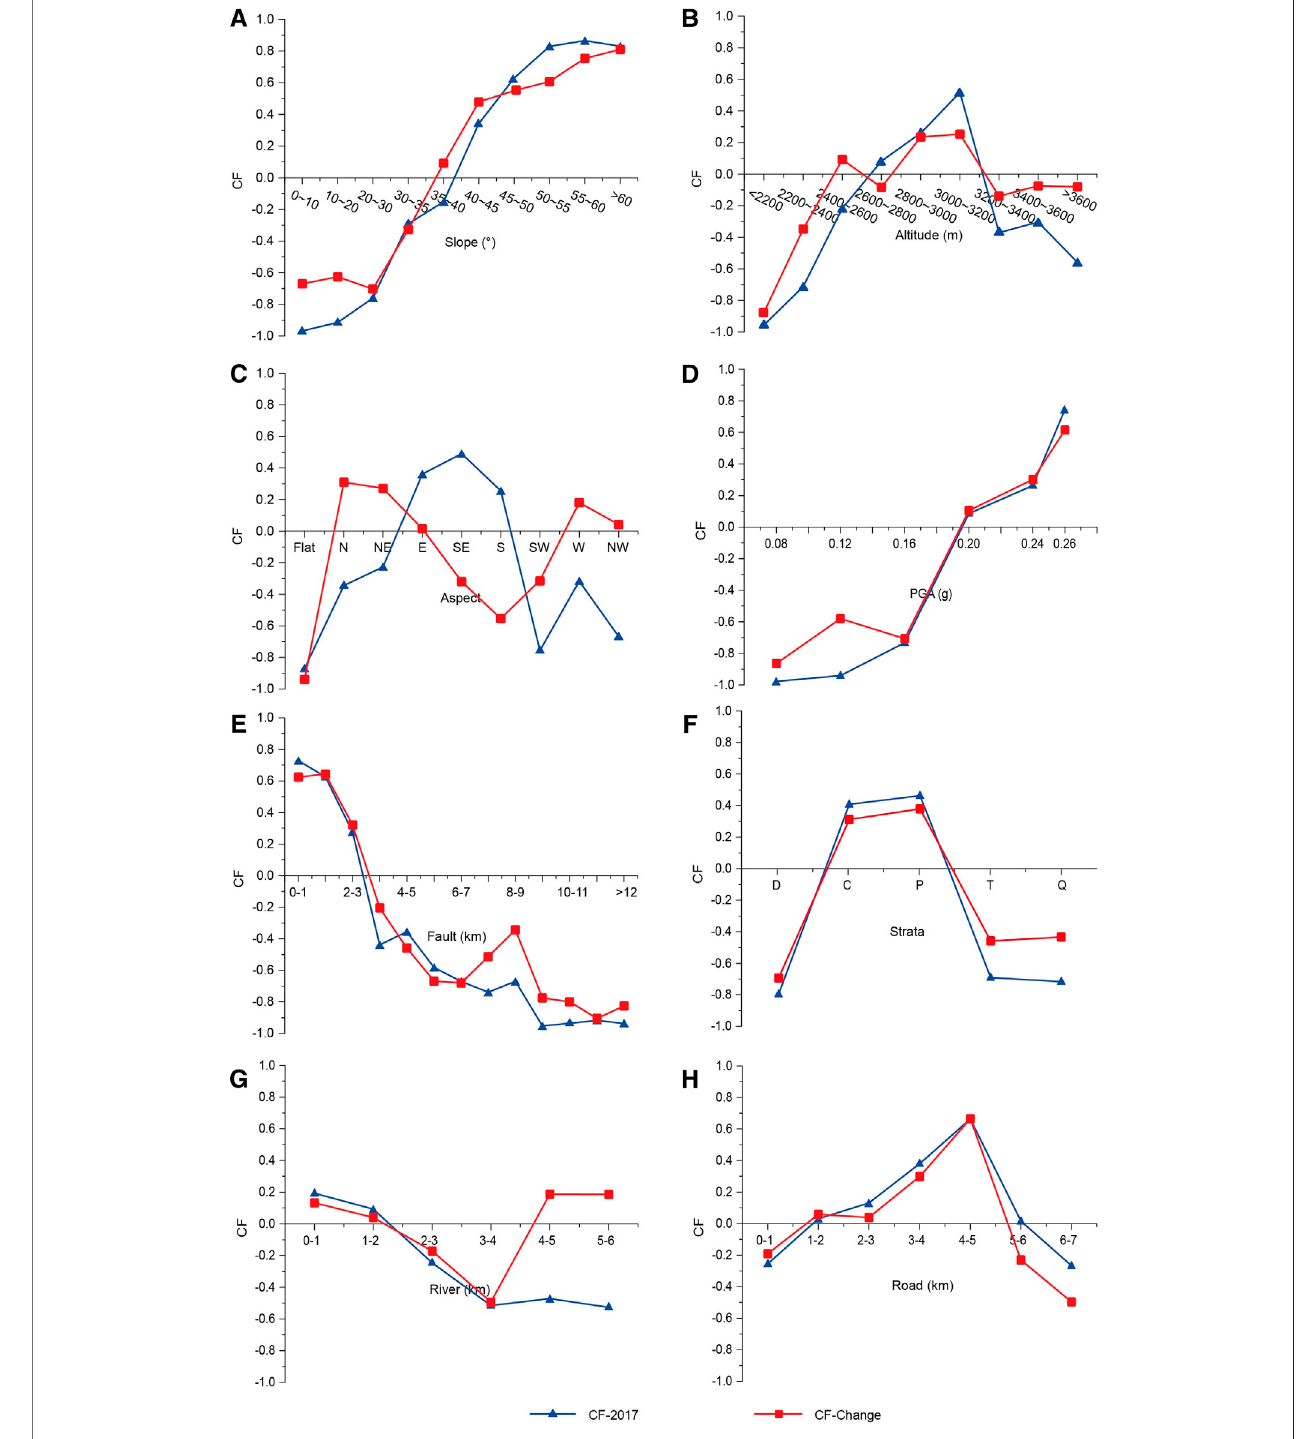
FIGURE13 | Susceptibilityofcoseismic landslides and post-seismic landslide change (A) Slope (B) Altitude (C) Aspect (D) PGA (E) Distance tofault (F) Strata (G) Distance to rivers (H) Distance to roads.